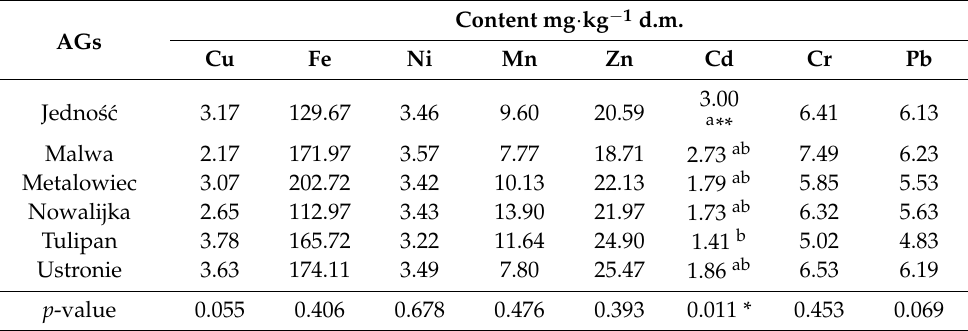
Table 11. The content of heavy metals in the roots of Daucus carota subsp. sativus growing in six allotment gardens of Gorzów Wielkopolski.